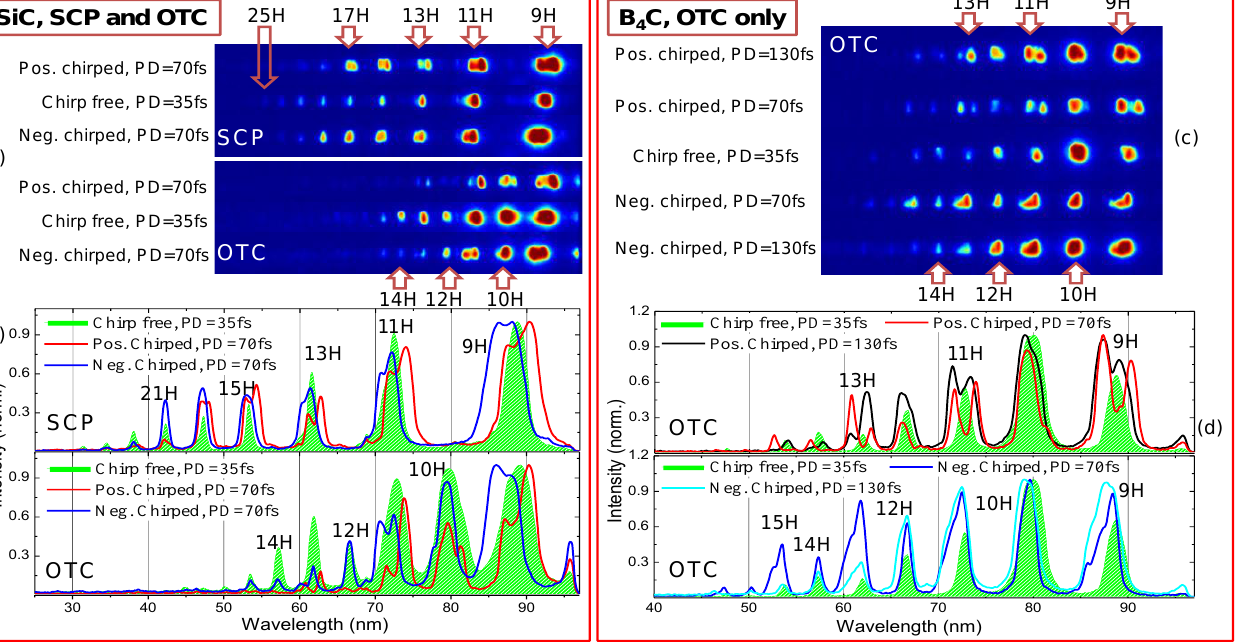
Figure 8. Calculated HHG spectra for PTC with I p = 21.5 eV were empirically determined through Equation (3) for Cr 3 C 2 LIP. Panel ( a ) shows the calculated spectrum of harmonics in the case of single-color pump. Through panels ( b – f ), different relations between I ω , I 2 ω , and φ 0 were consid- ered. Here I 0 = 1.65 × 10 14 W/cm 2 . SCP row presents the calculated HHG with only 800 nm field. Even stronger deviation in the case of OTC scheme was observed in the case of combination with positively/negatively chirped PPs. In Figure 7c,d, the black/red and blue/cyan solid line profiles present the results of interaction of 130/70 fs chirped pulses with B 4 C NP LIP.